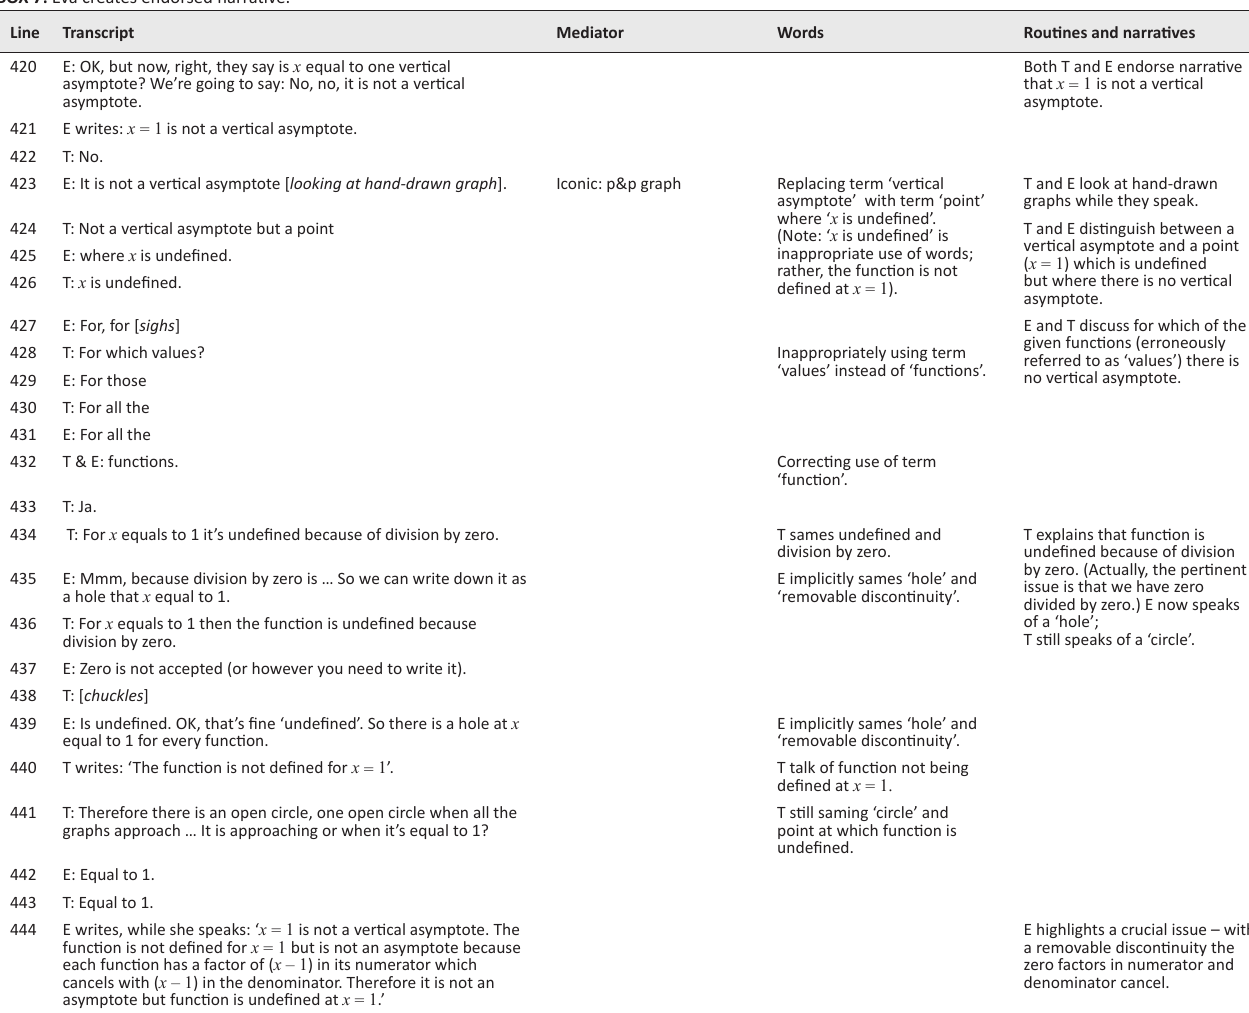
, y , y and y by Eva and 1 2 3 4